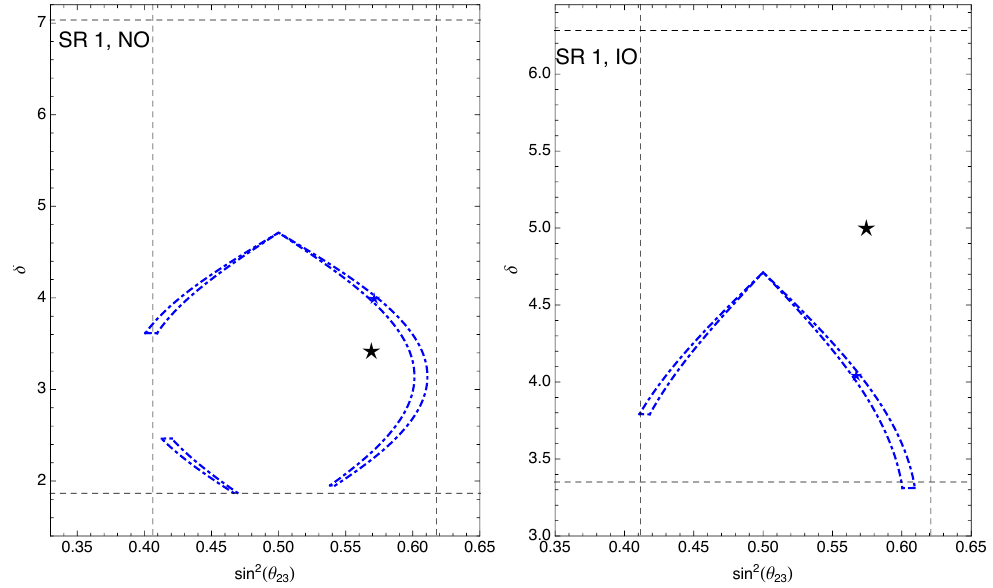
Figure 1 . Correlations between δ and θ 23 in blue for SR 1 for NO (left) and IO (right). The blue lines have been obtained by varying the model parameters θ and φ in their 3 σ ranges. The dashed lines show the experimental 3 σ ranges from nu-fit 5.0 . The blue (black) star represents the best fit value with (without) the presence of SR